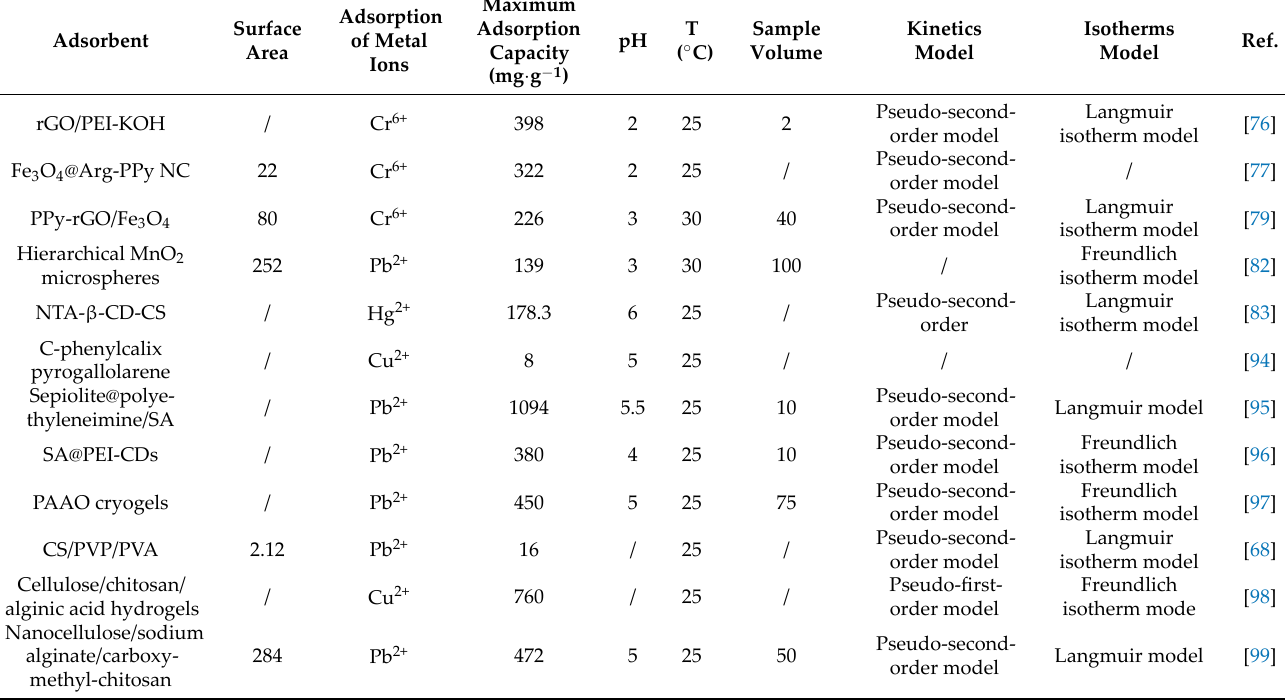
Table 2. The adsorption performance of other adsorbents for heavy metal